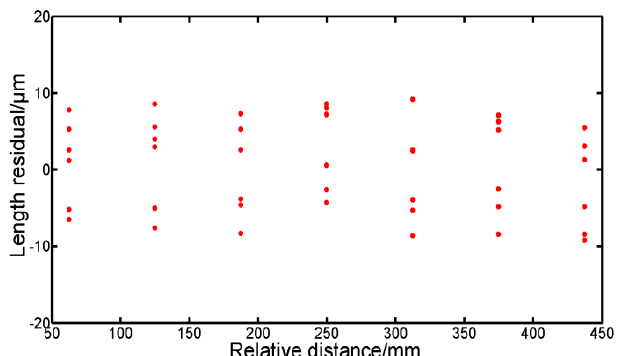
Figure 9. Distance residual between the measured results of our FSI-based system and the laser interferometer.